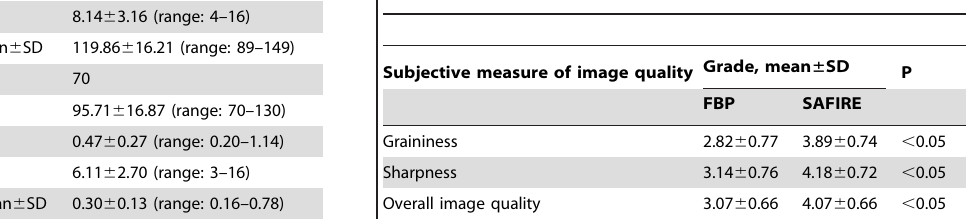
Table 2. Subjective image quality assessment of filtered back projection (FBP) and sinogram affirmed iterative reconstruction algorithm (SAFIRE) series at 70 kVp